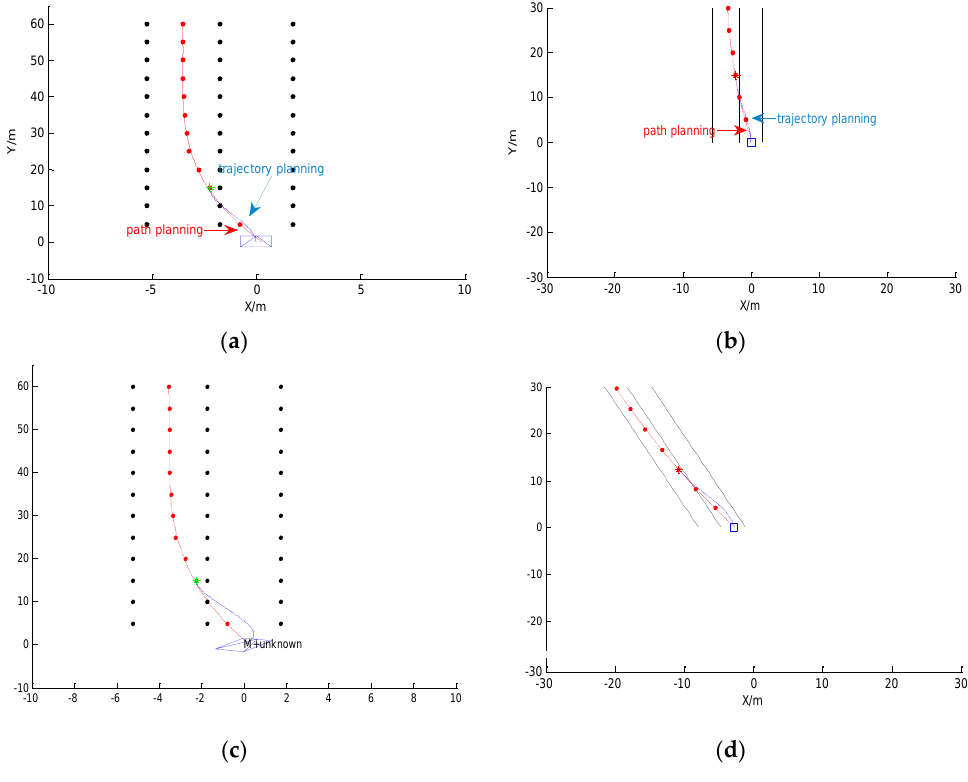
Figure 12. Lane changing. ( a ) Global coordinates of scene 1; ( b ) local coordinates of scene 1; ( c ) global coordinates of scene 2; ( d ) local coordinates of scene 2. Future Internet 2018 , 10 , x FOR PEER REVIEW